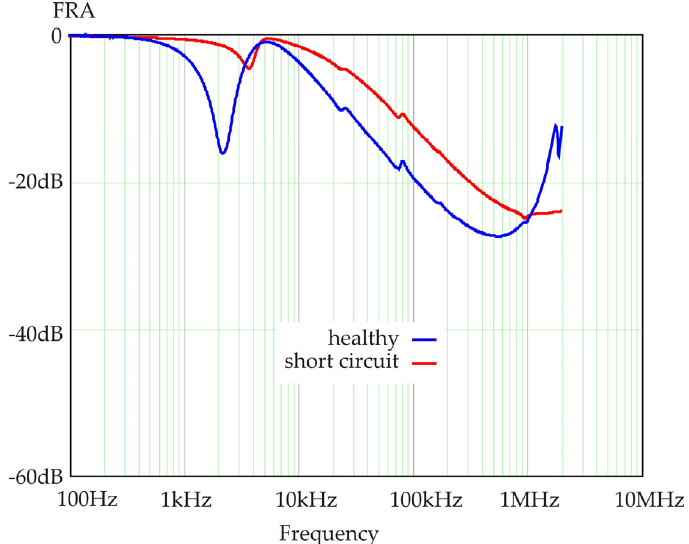
Figure 10. Frequency response measured on the real winding: blue—healthy winding; red—after introducing the short circuit between discs 9 and 10.